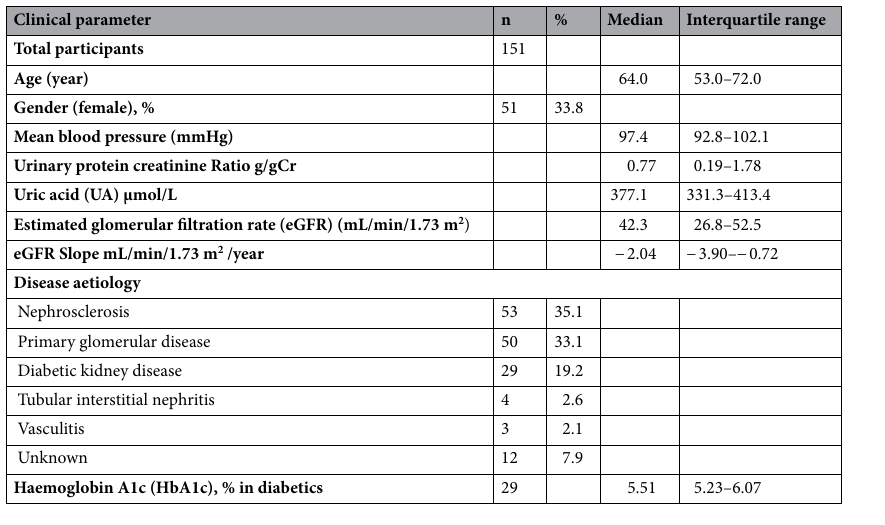
Table 1. Clinical background of study